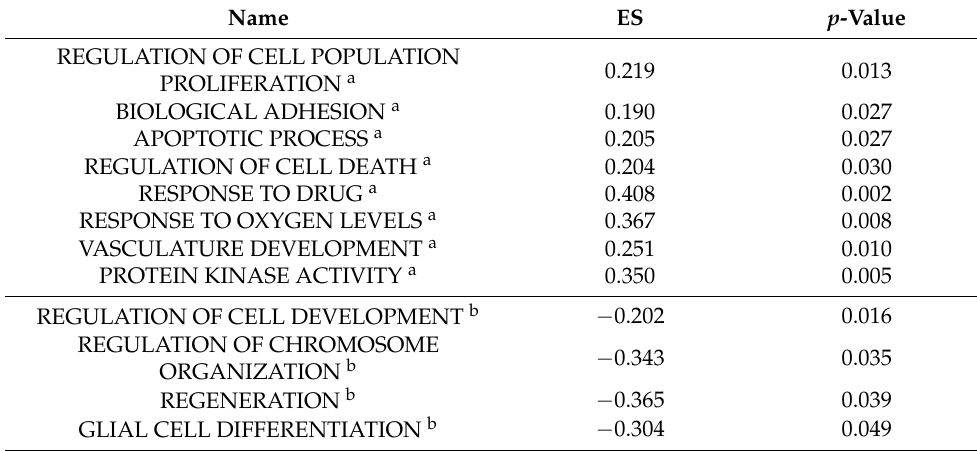
Table 3. Gene sets correlated with the resistant